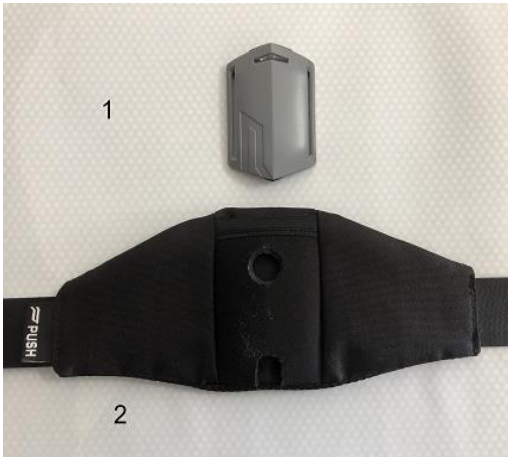
Figure 2. Sample 1: the Push Band 2.0 mobile inertial unit; Sample 2: the plyometric jumping belt supplied by the company.